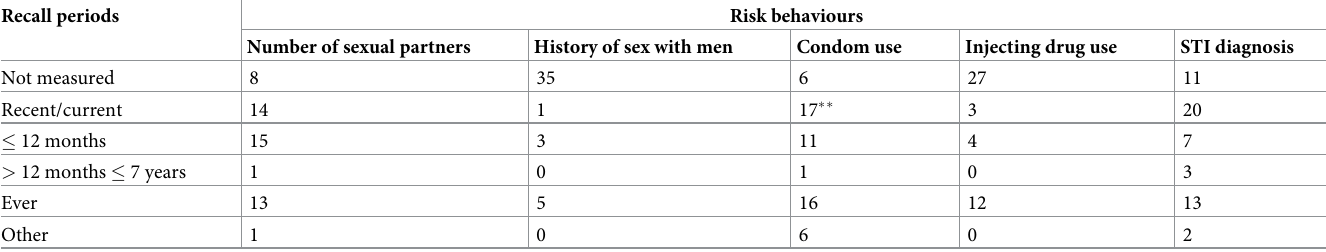
Table 5. Number of studies reporting various recall periods for selected risk behaviours �